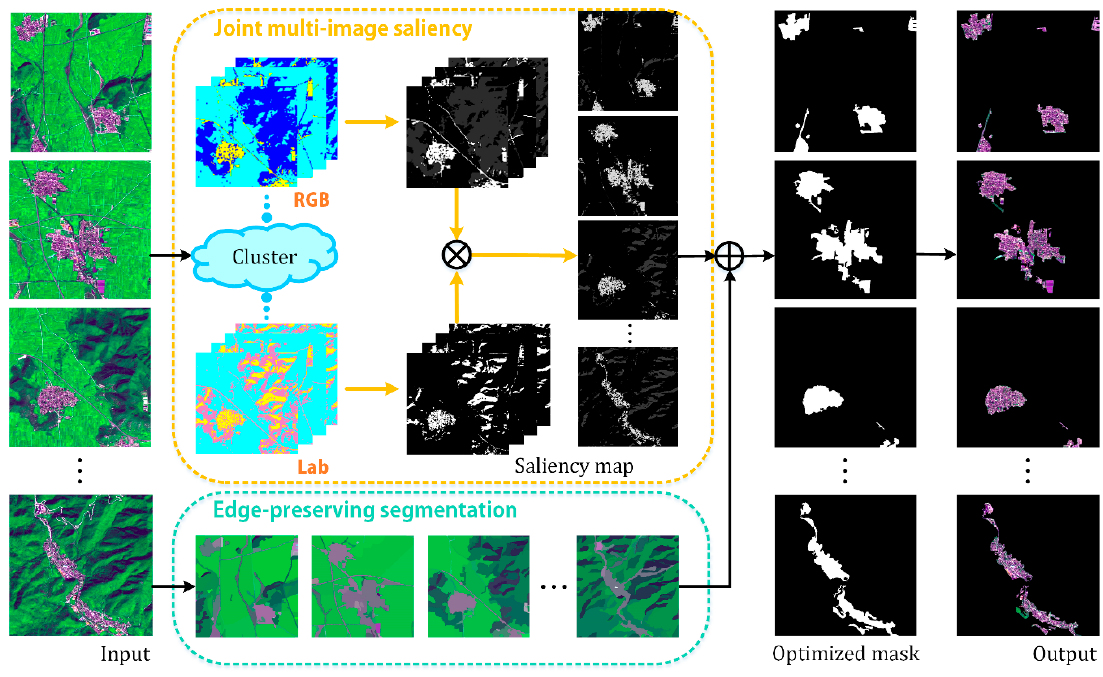
Figure 2. Joint multi-image saliency framework.